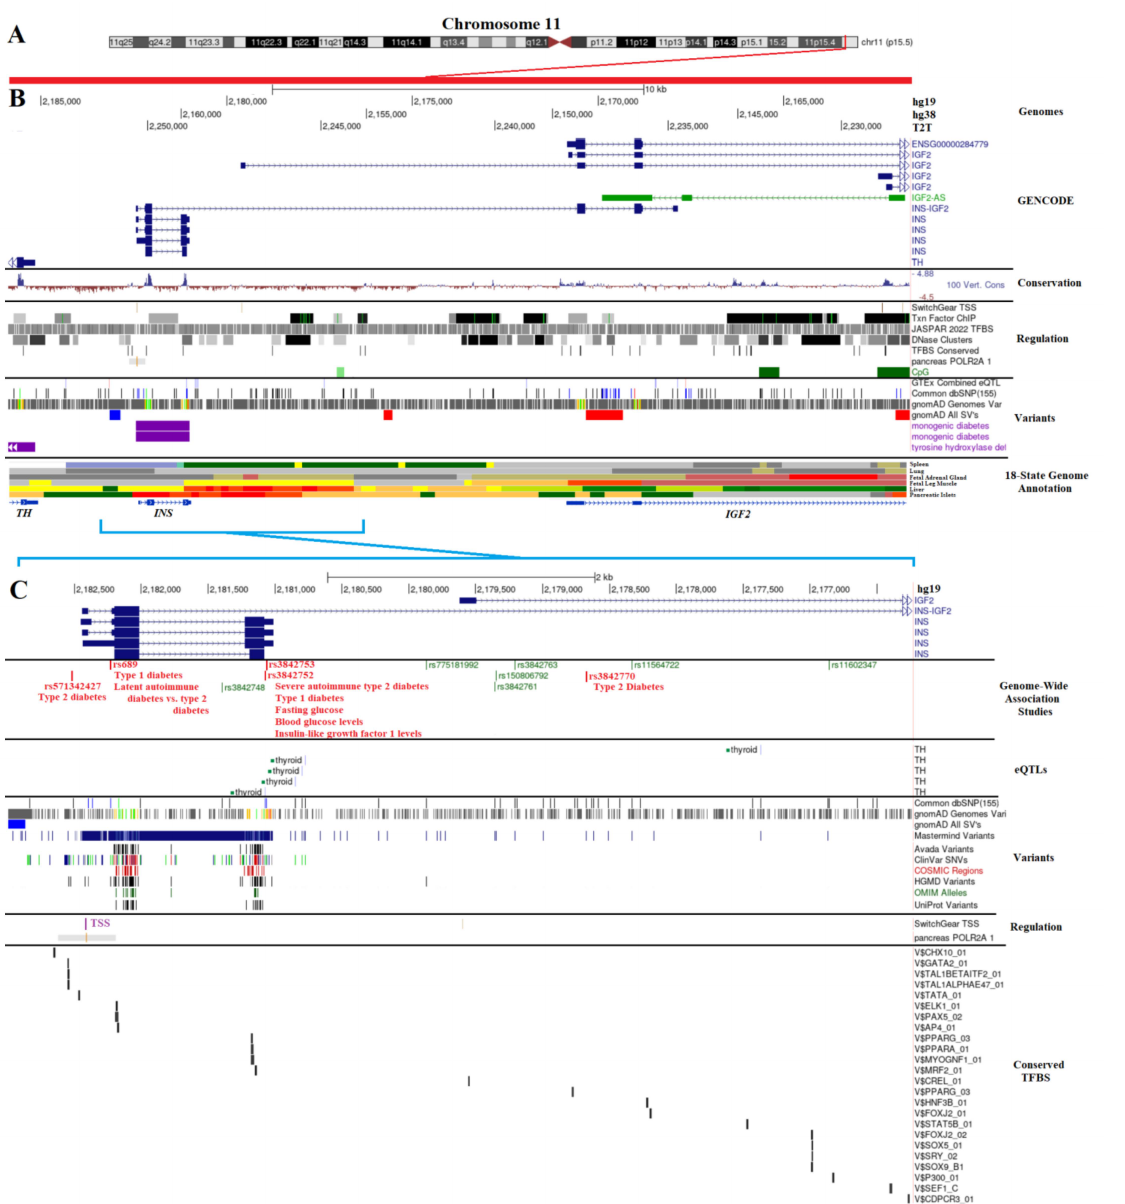
Figure 1. Genomic region of insulin. ( A ) The map of chromosome 11 with the Insulin ( INS ) gene region in red on the chr1(p15.5) segment. ( B ) Genome browser annotation (UCSC, https://genome. ucsc.edu/ (accessed on 6 December 2022) for a region near INS (hg19-chr11:2,161,620–2,185,936, hg38- chr11:2,140,390–2,164,706, T2T-chr11:2,228,043–2,254,072). This covers the region between Tyrosine Hydroxylase ( TH ) and Insulin-like growth factor 2 ( IGF2 ). At the top are the chromosome labels for three different human genome releases (hg19, hg38, and T2T). Below are known splicing isoforms of GENCODE, conservation (blue peaks represent conserved regions), various regulation datasets, known human variants, and the Roadmap Epigenomics 18-state genome annotation of several tissues, with pancreatic islets shown at the bottom. ( C ) Zoomed-in view of INS marked in cyan on Panel B (hg19-chr11:2,176,237–2,182,988, hg38-chr11:2,155,007–2,161,758, T2T-chr11:2,242,655–2,251,112). Shown are known Genome-Wide Association Study (GWAS) loci for biological traits with diabetes- connected SNPs in red, known expression quantitative trait loci (eQTLs) from GTEx, known human variants from various databases, known regulation sites, and conserved transcription factor binding sites (TFBS). All panel colors from the UCSC genome browser extractions can be found within track information within the browser, as we have used default color schemes from